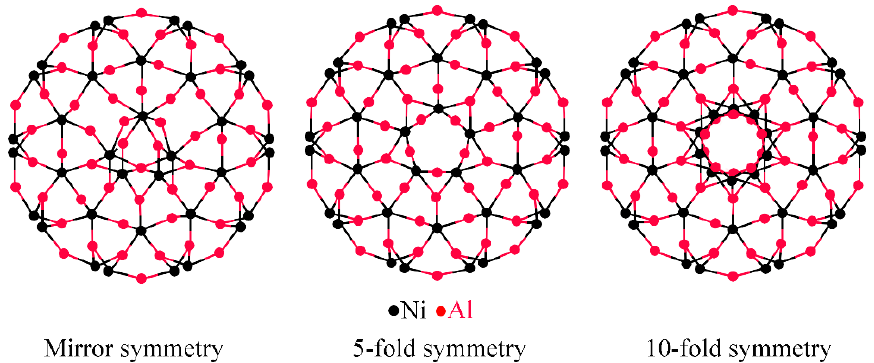
Figure 7. Models of decagonal clusters with three different symmetries (red dots indicate Al atoms, black dots transitional atoms. Reproduced from reference [95] with permission).